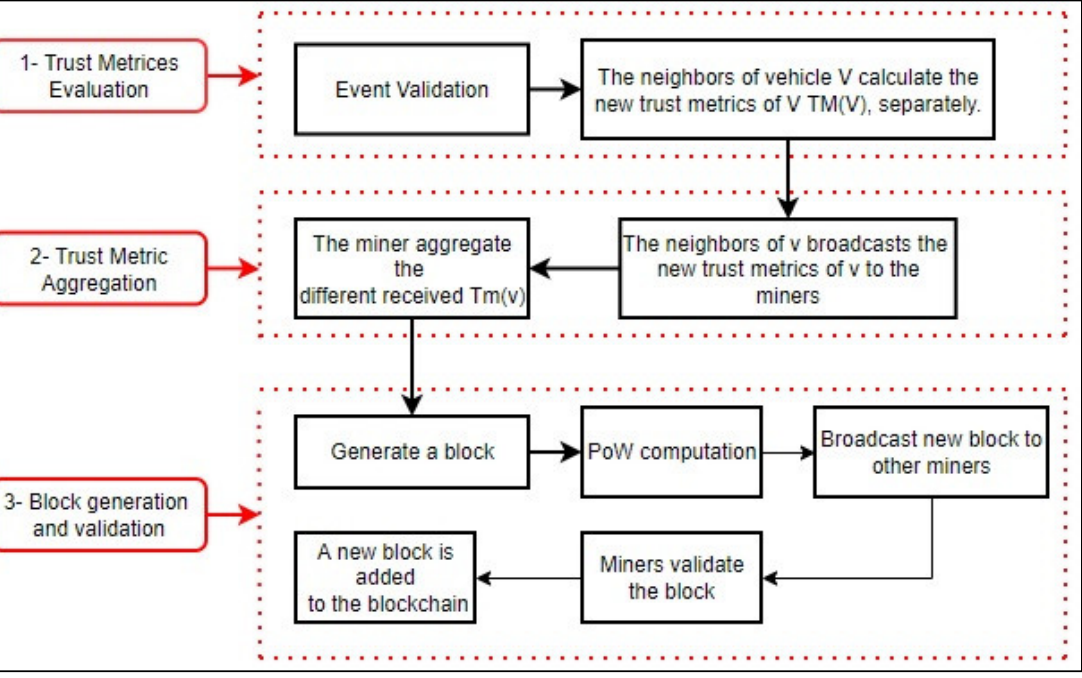
Figure 1. The different phases of the proposed BC-TMF.